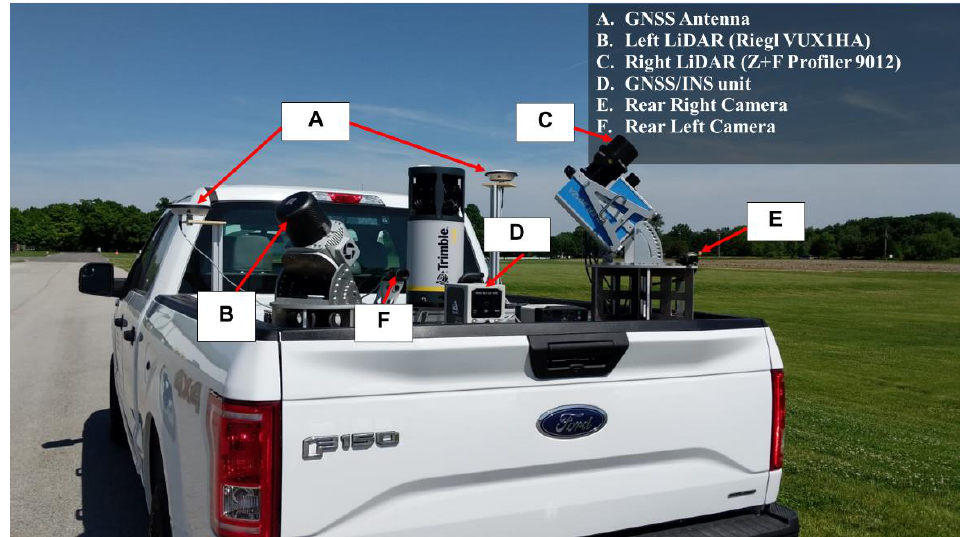
Figure 5. Configuration of the wheel-based mobile LiDAR mapping system used for the acquisition of point clouds along MSE walls.